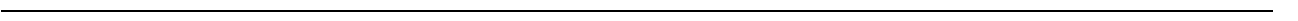
Fig. 1 Identi fi cation of BRE as a genetic interactor of BRCA2 using a MSCV-based insertional mutagenesis screen. a Schematic representation of MSCV- mediated insertional mutagenesis in Brca2 conditional mouse ES cells. Brca2 KO/KO cells generated after PGK-CRE-mediated deletion of the conditional allele are not viable. Mutagenesis by MSCV-CRE can generate viable Brca2 KO/KO ES cells. b Southern blot analysis of HAT-resistant ES cell colony that lost conditional Brca2 allele ( Brca2 KO/KO ; Clone 3d ) after MSCV-CRE transduction. Upper band: conditional allele ( CKO ); lower band: knock-out allele ( KO ). c Quanti fi cation of Bre expression by real-time RT-PCR in Brca2 conditional mutant ( Brca2 CKO/KO ) and Brca2 KO/KO ES cells with viral insertion at chr: 5qB1 ( Brca2 KO/KO ;Clone 3d ). Data are represented as mean ± s.d. Top panel shows the distance between viral insertion and start of fi rst exon of Bre . d Expression of HA-tagged BRE from MSCV LTR in Brca2 CKO/KO clones. Two independent clones Clone #1 and Clone #2 analyzed by western blot analysis were used further. Left panel shows the scheme of relevant alleles of Brca2 CKO/KO ; MSCV-BRE ES cells. e Southern blot analysis of HAT-resistant ES cell colonies after CRE-mediated deletion of conditional allele in Brca2 CKO/KO ; MSCV-BRE ES cells to identify Brca2 KO/KO clones (marked with solid stars), upper band: conditional allele ( CKO ); lower band: knock-out allele ( KO ). Schematic diagram of CRE-induced loss of conditional Brca2 allele in Brca2 CKO/KO ; MSCV-BRE cells is shown at the top. f Upper panel shows western blot for BRCA2 knockdown by two different shRNAs (#1 and #2) and a non-speci fi c (NS) control and HA-BRE expression in MCF7 cells that were stably expressing either empty vector (MCF7Neo) or vector expressing HA-BRE (MCF7BRE). GAPDH was used as a loading control. Growth of MCF7 cells after BRCA2 knockdown in the presence or absence of HA-BRE expression represented in the lower panel. Fold growth was calculated by dividing cell counts on particular day with cell count on day 1. P values are shown in Supplementary Table 2. P values